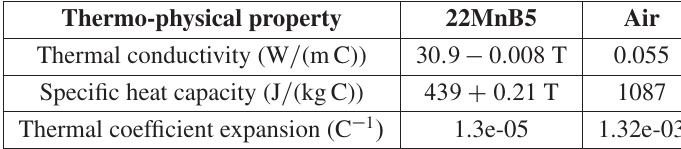
Table 7. Thermo-physical properties of Boron steel as function of temperature T (in ı C) and air. VUMAT subroutine for the uni-axial tension tests of tensile specimens at room, elevated and air cooling temperatures.